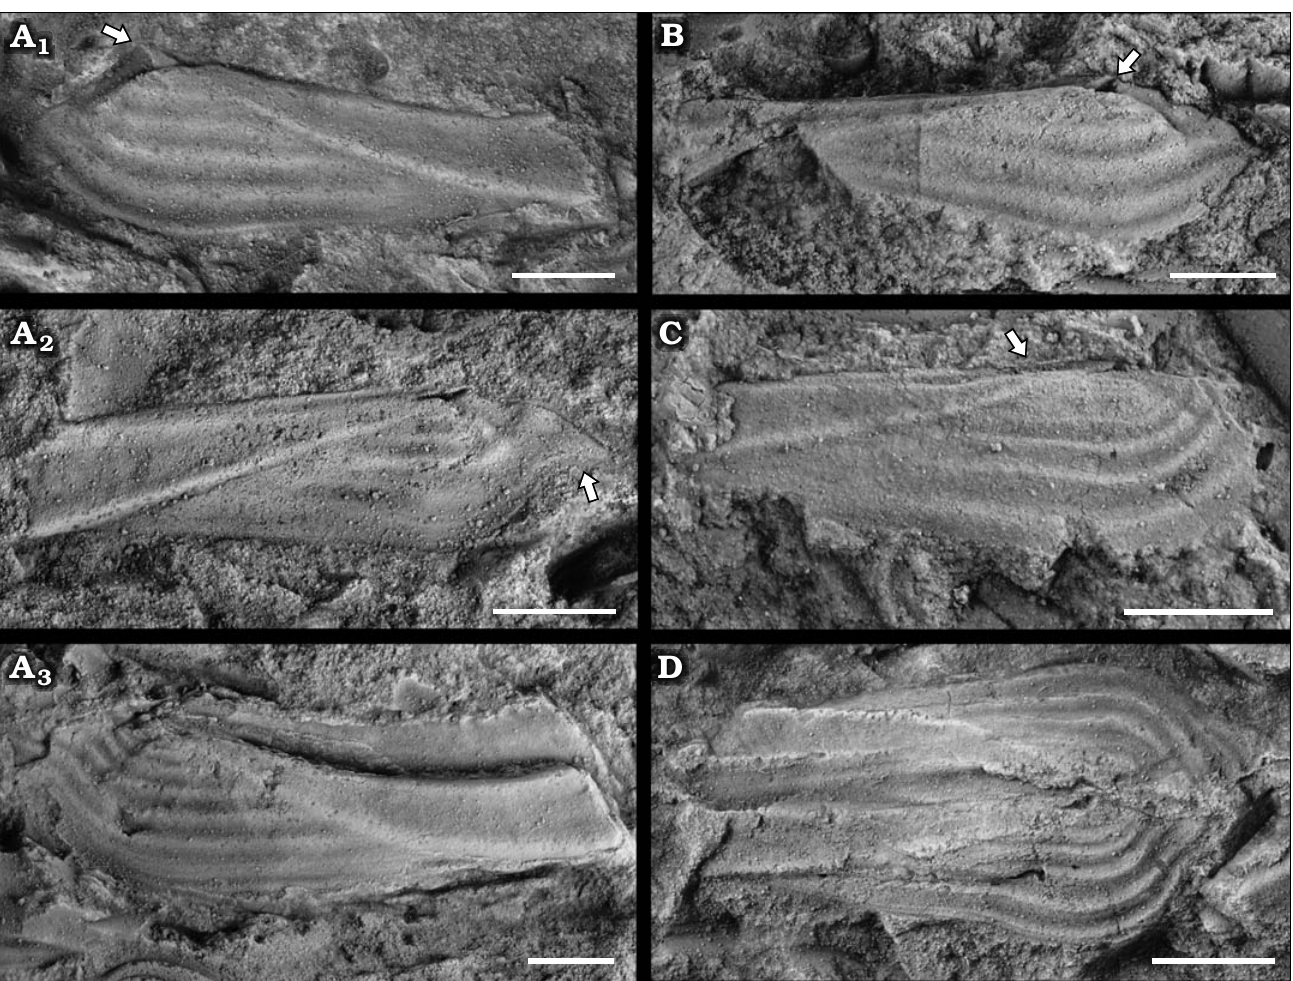
Fig. 3. Pachydomid bivalve Leinzia similis (Holdhaus, 1918) (sensu stricto), composite molds, Rio do Rasto Formation, Guadalupian (Permian), Paraná Basin, Brazil. A . DGP/7-88, left valve (A 1 ) with well-defined, forwardly inclined, triangular socket (arrowed); right valve (A 2 ), note the deformed anterior rostrum margin of the shell (arrowed); splayed open valves (A 3 ). B . DZP-20417, right valve, note the well-developed triangular blunt tooth (arrowed). C . DZP-20416A, right valve showing well-defined escutcheon (arrowed). D . DGP/7-86, a slightly deformed specimen with articulated valves and broken anterior margin, note the straight slightly curved posterior margin of the shells. Scale bars 5 mm.